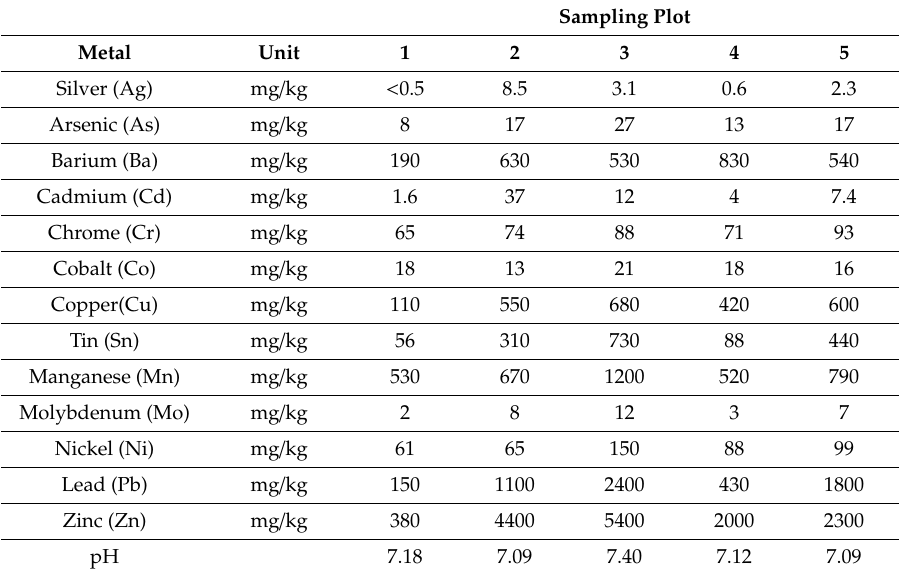
Table 1. Trace element (TE) concentrations and pH from the 2015 exploratory soil sampling of the Longueuil, Qu é bec industrial